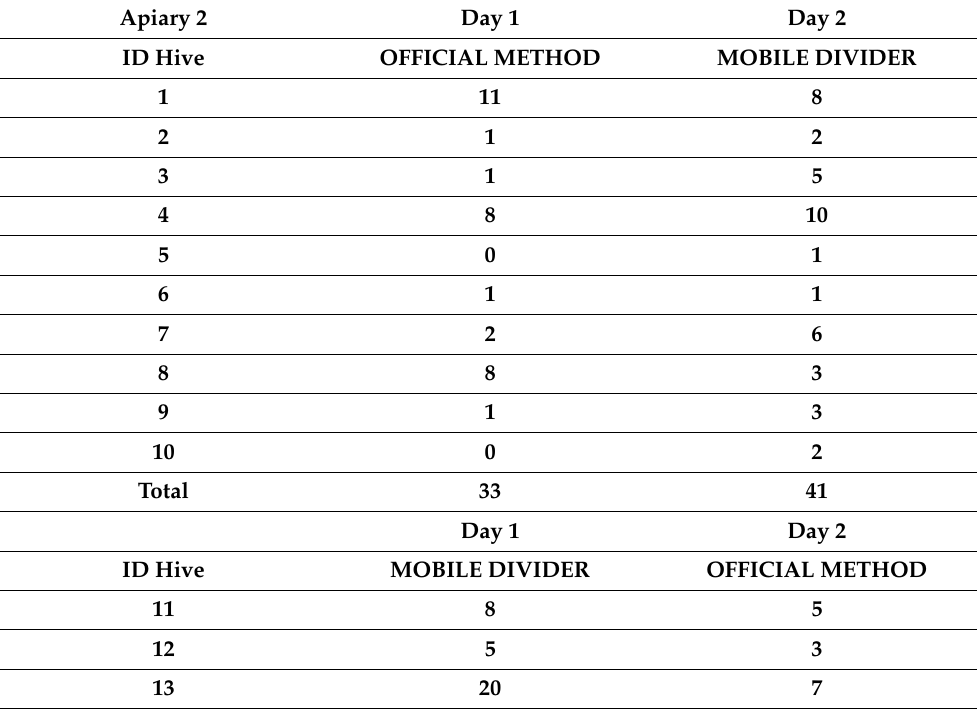
Table 4. Number of detected A. tumida in apiary 2 with the two methods on day 1 and day